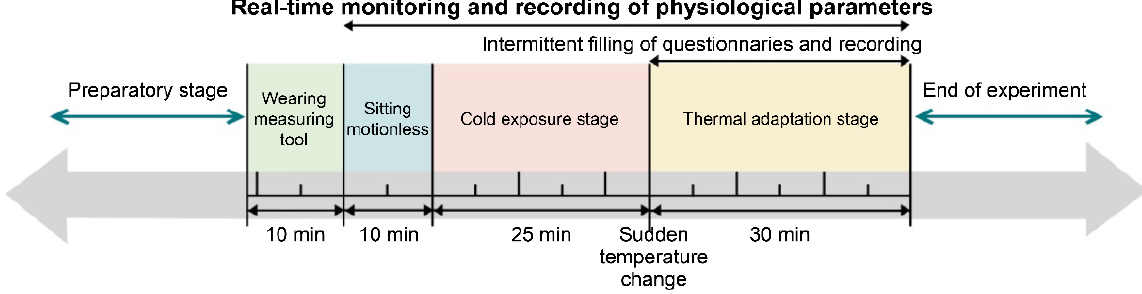
Figure 3. Experimental procedure.